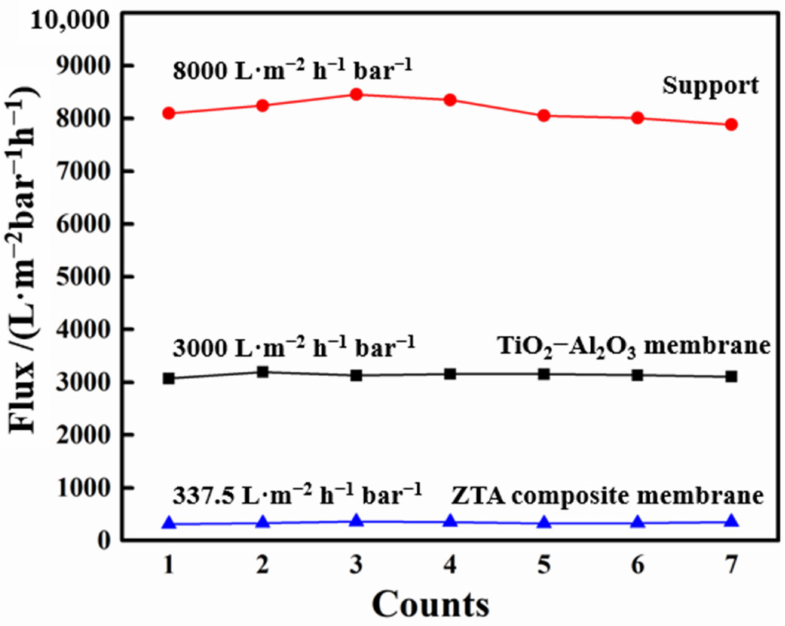
Figure 7. Pure water flux evaluation of support, TiO 2 –Al 2 O 3 membrane and ZTA composite mem- brane.